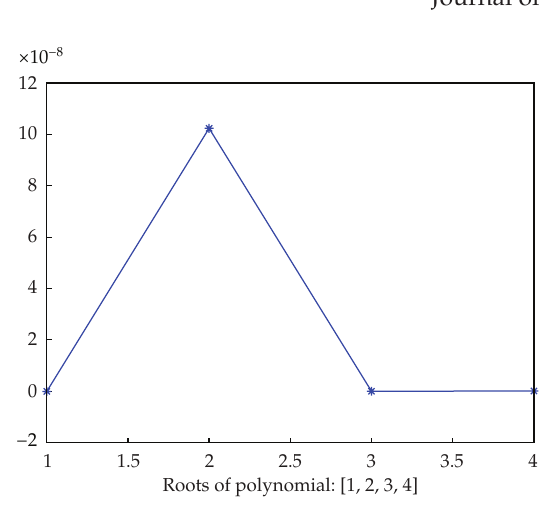
Figure 4: Error of Fiedler’s method for polynomial with arbitrary